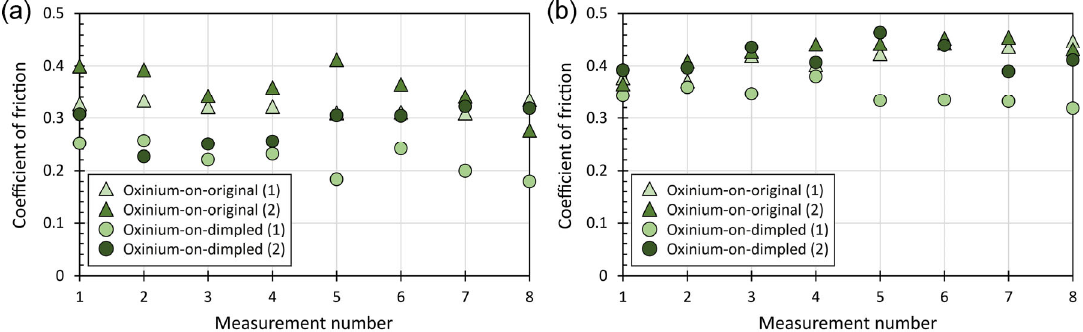
Fig. 7 Results of friction coefficient for oxinium femoral head using (a) PBS and (b) model